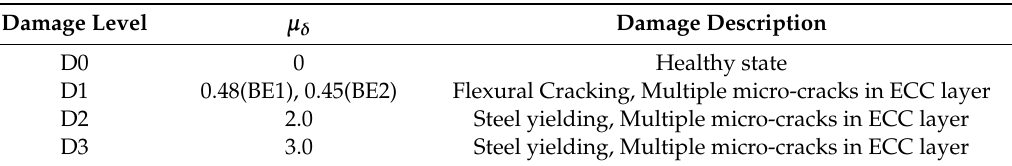
Table 3. Three di ff erent damage levels of BE1 and BE2. Table 3. Three different damage levels of BE1 and BE2.